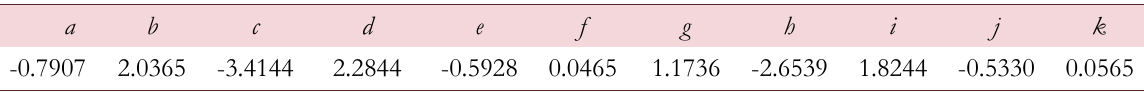
Table 6: Coefficients of developed crack deflection angle